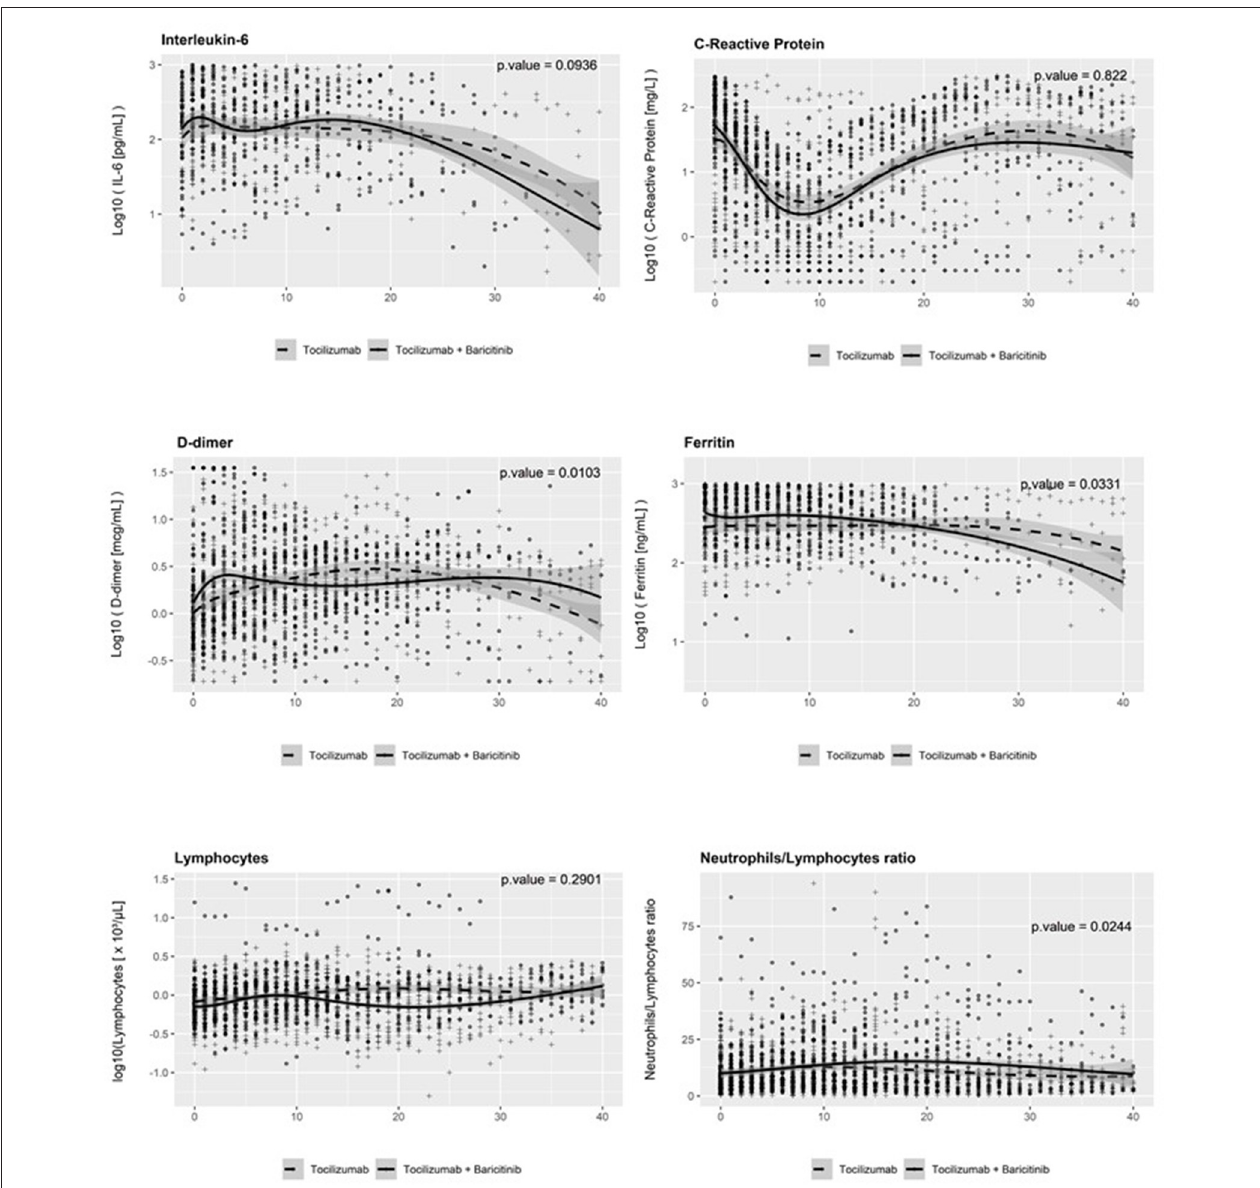
FIGURE 4 | Temporal changes in serum levels of biomarkers from baseline. IL-6,